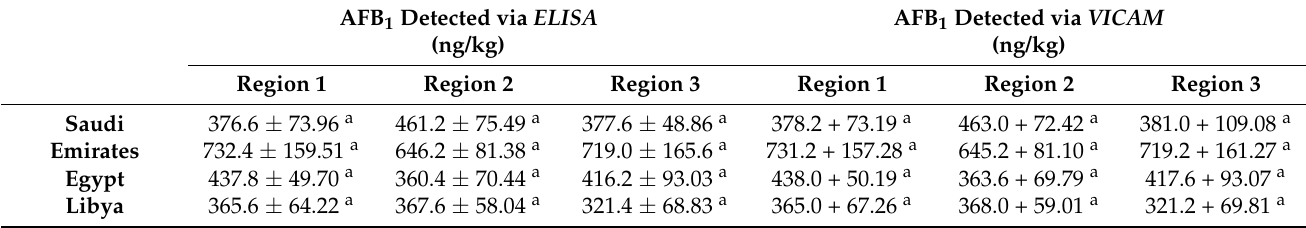
Table 5. Determination of Aflatoxin B 1 in manufactured feed collected from camel pasture areas of the Arabian Peninsula and North